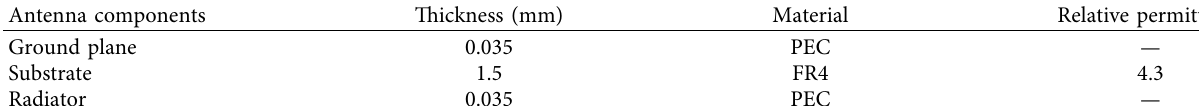
Table 1: Antenna materials and thickness.